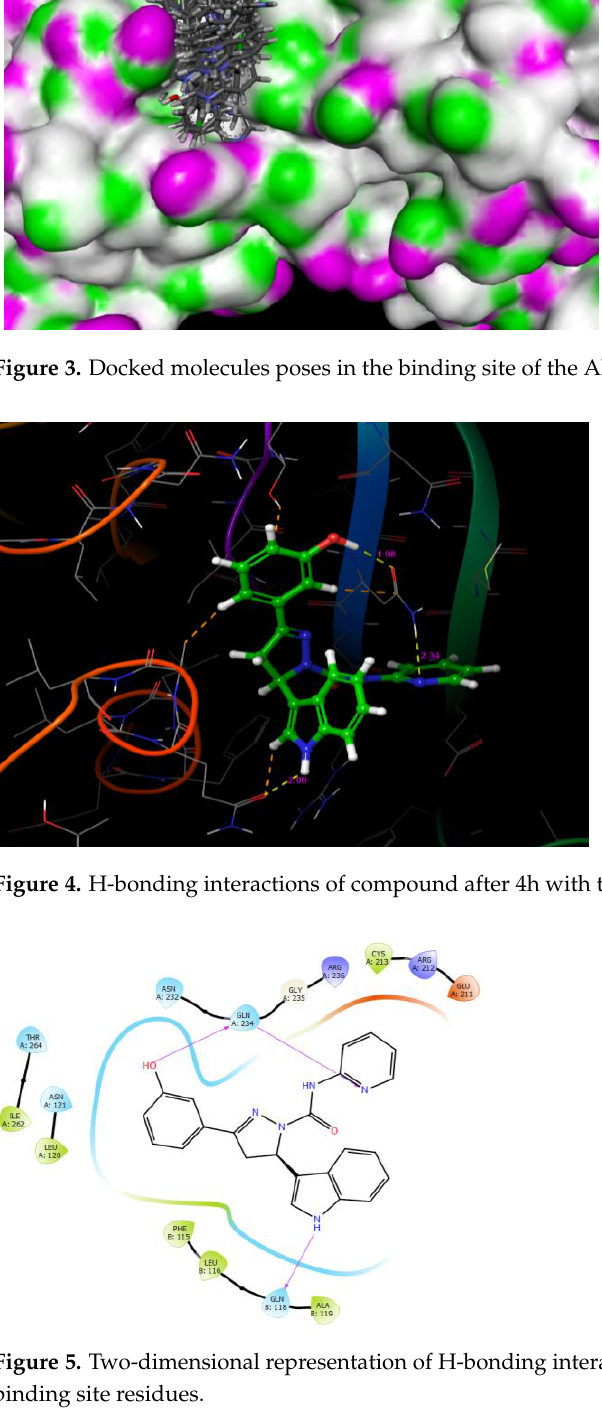
Figure 5. Two-dimensional representation of H-bonding interactions of compound after 4 h with the binding site residues.